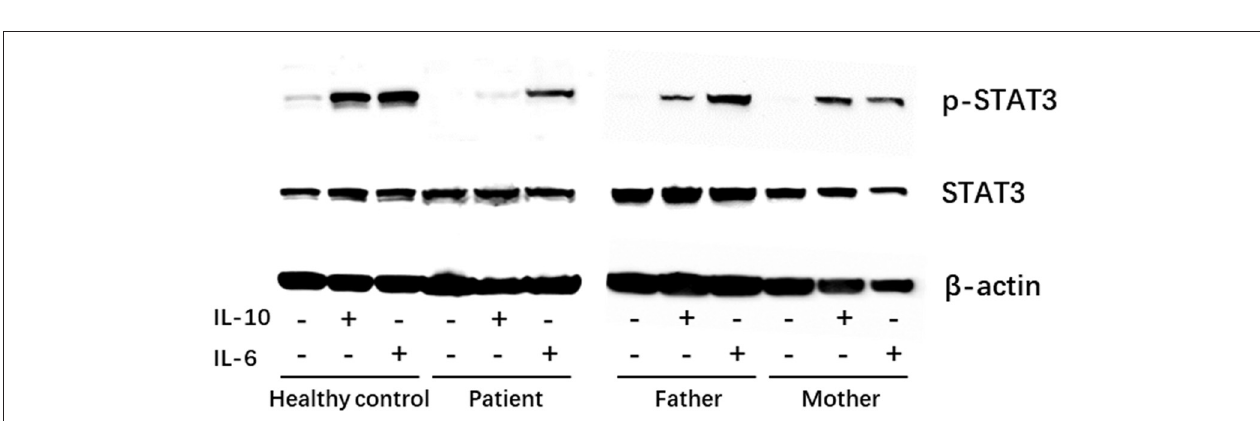
FIGURE 2 | Western blot showing the patient had normal expression of p-STAT3 in peripheral blood mononuclear cells (PBMCs) in response to IL-6 (positive control) stimulation but showed defective STAT3 phosphorylation under IL-10 stimulation. − , untreated; + ,